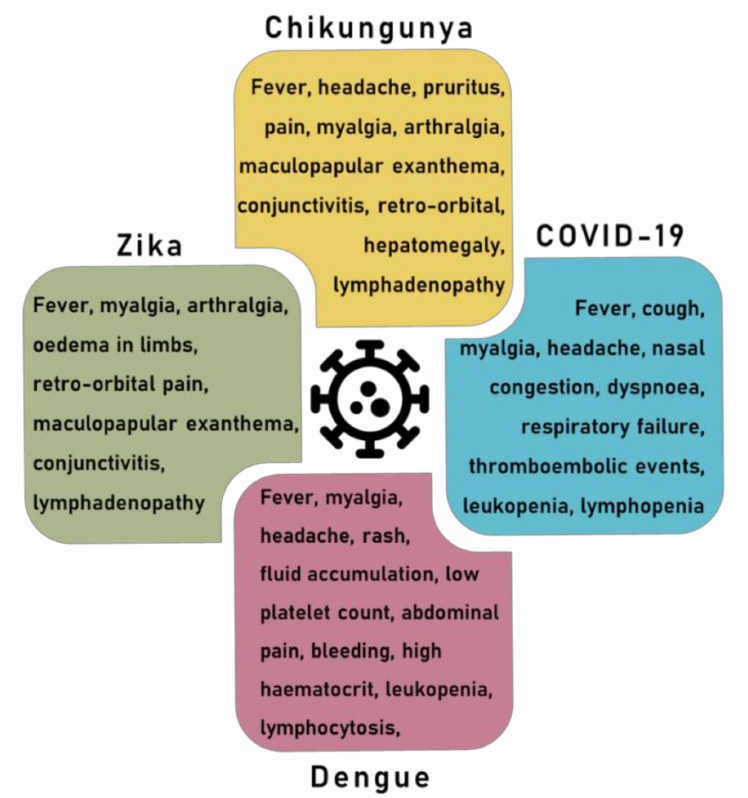
Figure 1. The main symptoms related to COVID-19, dengue, Zika, and